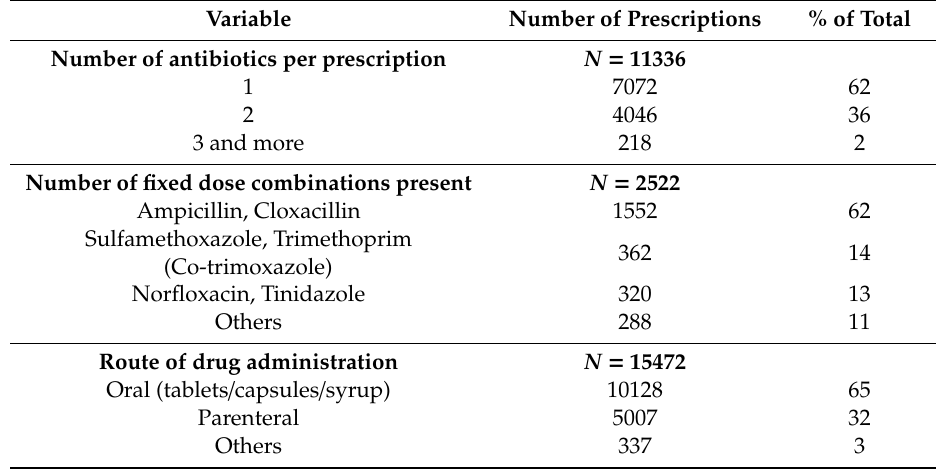
Table 2. Number of antibiotics per prescription, fixed dose combinations, and route of administration of antibiotics for the prescriptions collected from informal healthcare providers in rural